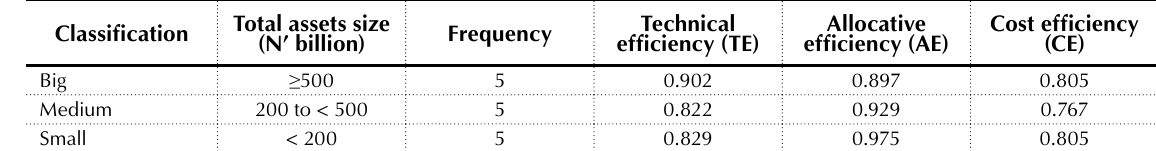
Table 10 . Measured mean efficiency of the deposit money banks in 2008